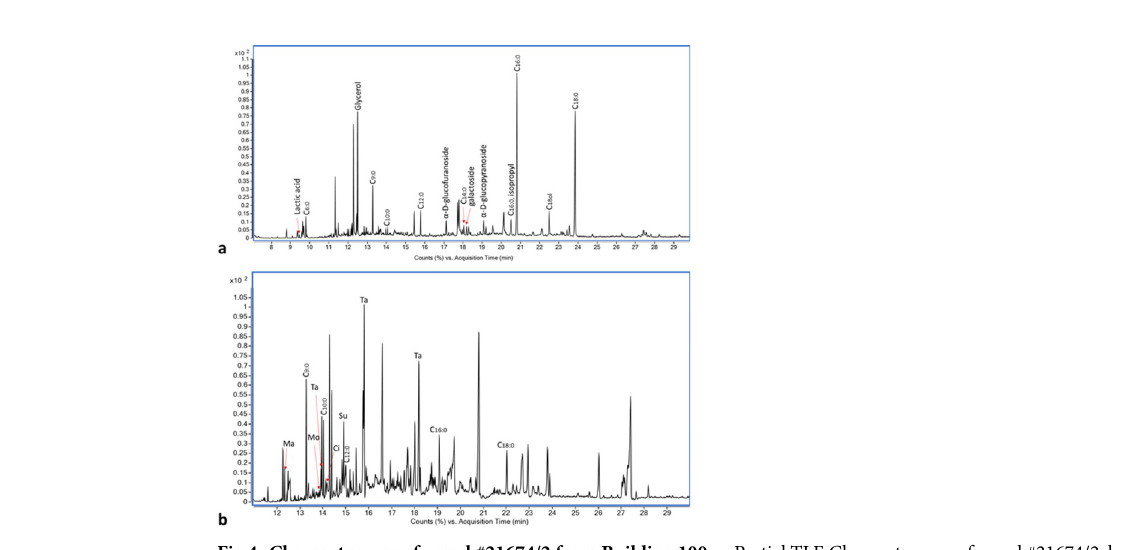
Fig 4. Chromatogram of vessel #21674/2 from Building 100. a. Partial TLE Chromatogram of vessel #21674/2. b. Partial WM Chromatogram of vessel #21674/2. Cx:y = fatty acid with x carbons in its chain and y is the number of double bonds; Cxol = alcohol with x carbons in its chain; Ma = malic acid; Mo = malonic acid; Ta = tartaric acid; Ci = citric acid; Su = succinic acid. Derivatization information was omitted for clarity. For details see S3 Fig.